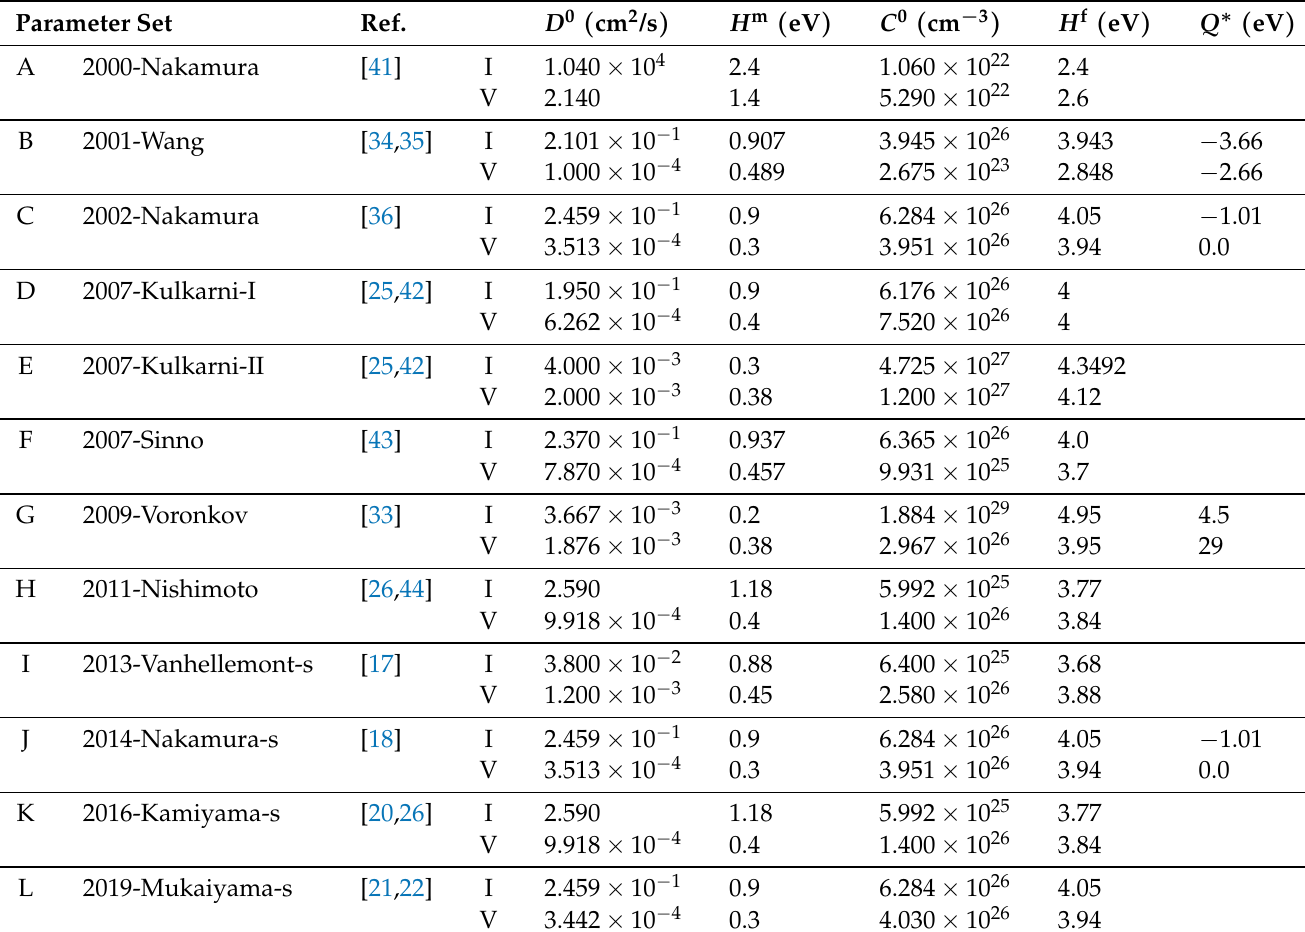
Table 1. Summary of considered point defect parameter sets defined by Equations (3)–(5). Suffix “-s” denotes parameter sets with the thermal stress influence, see Table 3 for the relevant parameters.